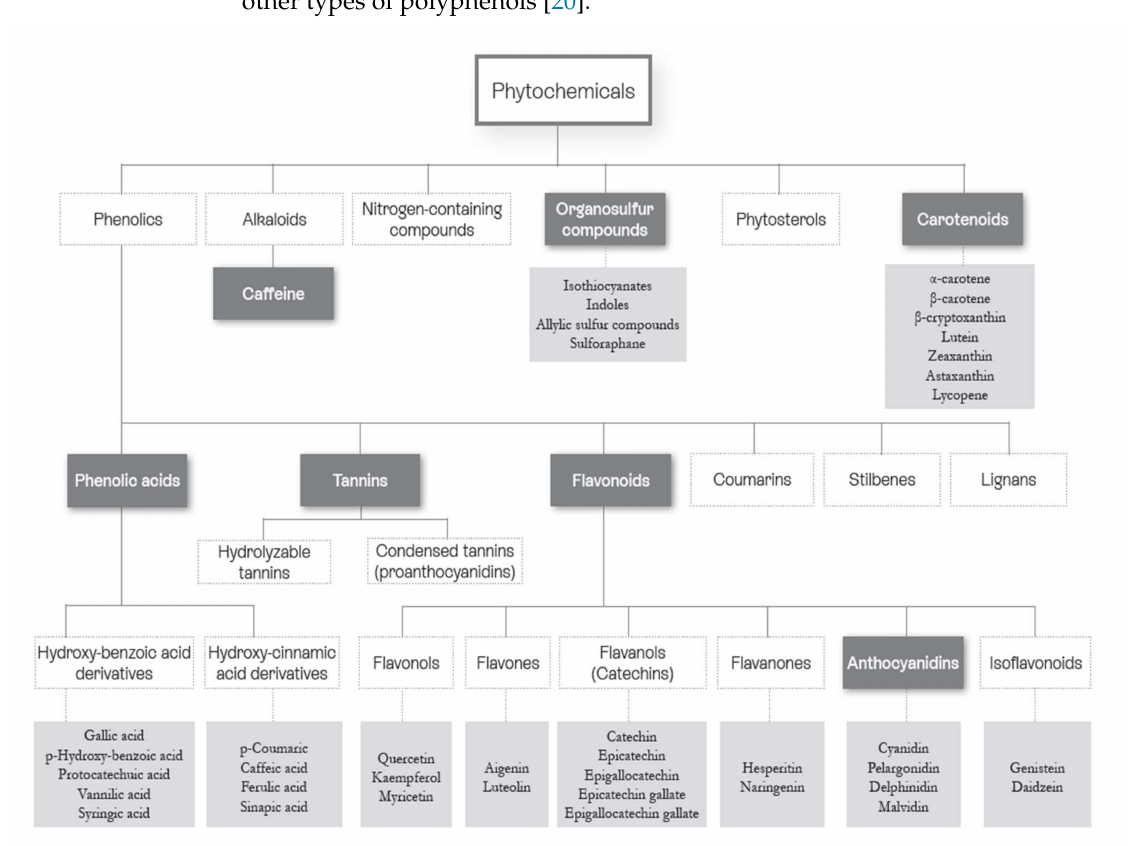
Figure 2. Classification of the main phytonutrient families (modified from [6]). Dark grey: Phytonu- trients Families. Light grey: Phytonutrients